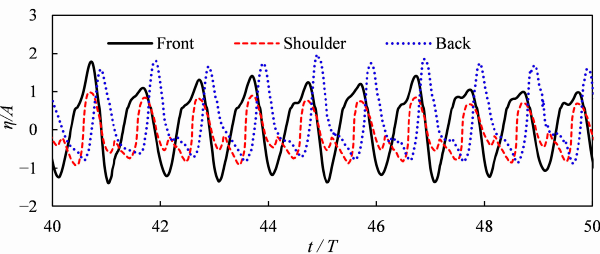
Figure 9. The measured free surface elevation time histories (front, shoulder, and back) under wave conditions of ( T = 1.15 s, A = 0.075 m).